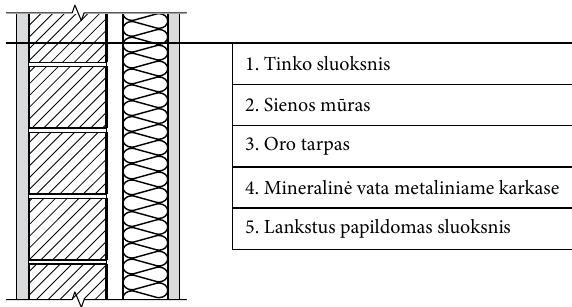
Fig. 1. A principle view of multilayer